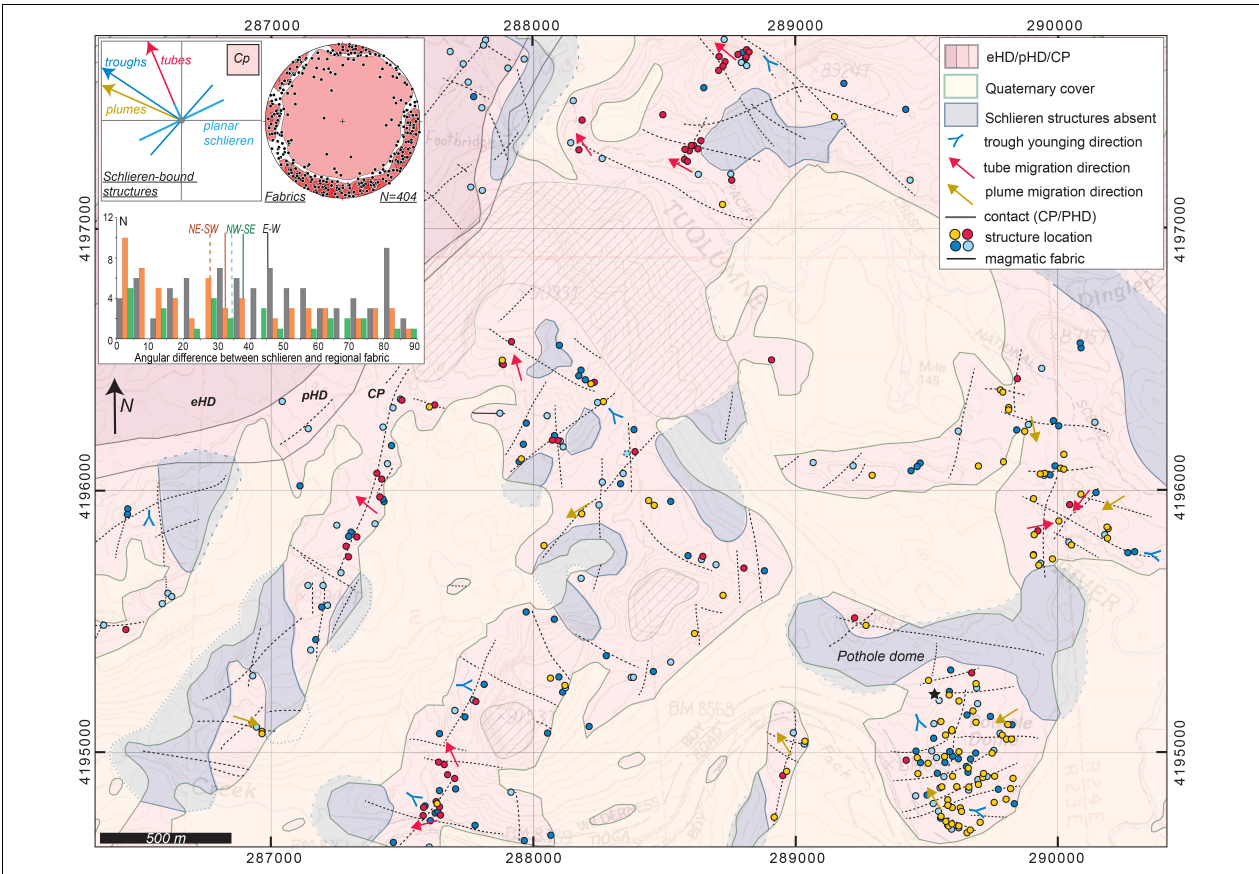
FIGURE 6 | Magmatic structures field data summary of the Glen Aulin area, NW quadrant. Bold lines mark major unit contacts. Hatching indicates unmapped areas. The trend of steeply dipping (70 ◦ –90 ◦ ) magmatic foliations is shown by dashed lines. Magmatic lineations are steeply plunging, regardless of the strike of the foliation. The locations of different schlieren-bound structures are shown by colored dots (light blue-planar schlieren; dark blue-trough; red; tube; yellow; plume). Y or arrow symbols are oriented in the direction of measured migration/younging. Inset box shows the domain-scale magmatic foliation summary on a stereonet, and a summary of average younging/migration orientations shown with arrows. For Glen Aulin and Young Lakes domains, angular difference measurements between the foliations and schlieren are shown as a histogram in the inset box, color-coded by fabric type. eHD-Equigranular Half Dome granodiorite. pHD-Porphyritic Half Dome granodiorite; CP-Cathedral Peak granodiorite; Co-ordinate system used: UTM NAD27 zone 11S.